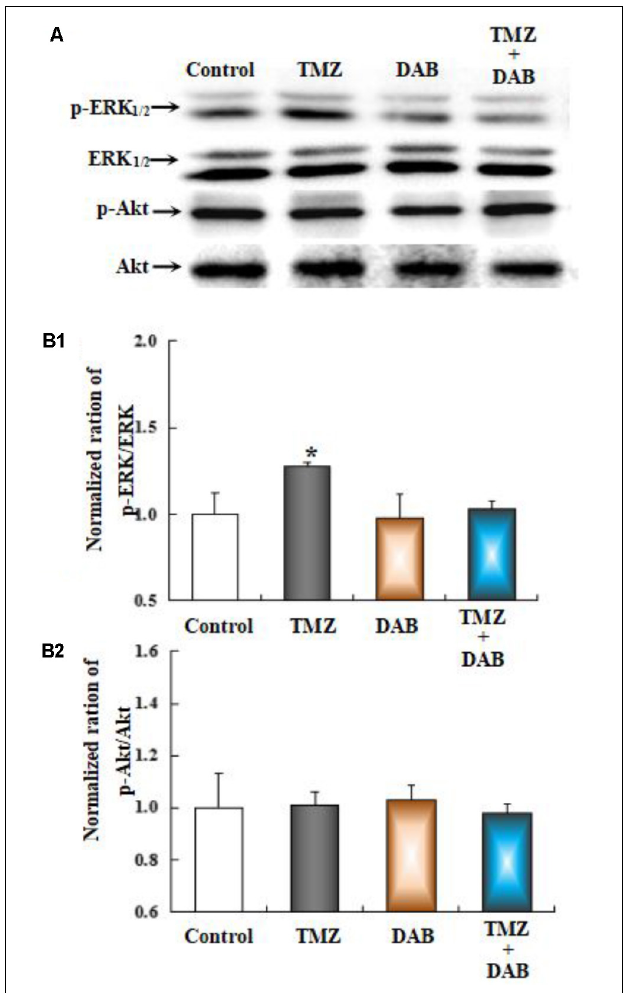
FIGURE 5 | The upregulation of TMZ-induced ERK 1 / 2 phosphorylation in U251 cells required glycogenolysis. (A) Cells were incubated for 20 min in the absence of any drug (Control) or in the presence of 5 µ M TMZ. In some experiments, 10 mM DAB, an inhibitor of glycogenolysis, was added 4 h before the addition of TMZ. (B1) Mean ERK phosphorylation was quantified as ratios between p-ERK 1 / 2 and ERK 1 / 2 . (B2) Average Akt phosphorylation was quantified as ratios between p-Akt and Akt. Similar results were obtained from three independent experiments. SEM values are indicated by vertical bars. ∗ Indicates a statistically significant ( P < 0.05) difference from the negative control